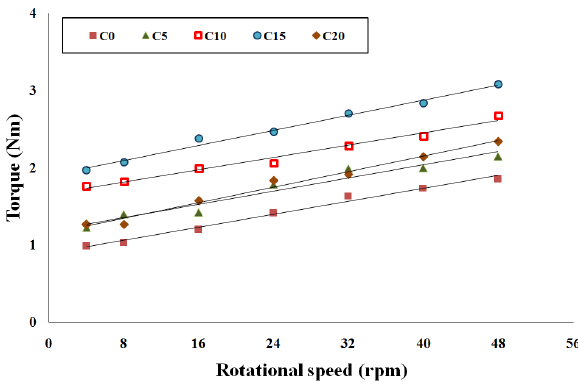
Figure 10: Evolution of the torque with rotational speed of concrete with different percentage of LF contents in the CS.